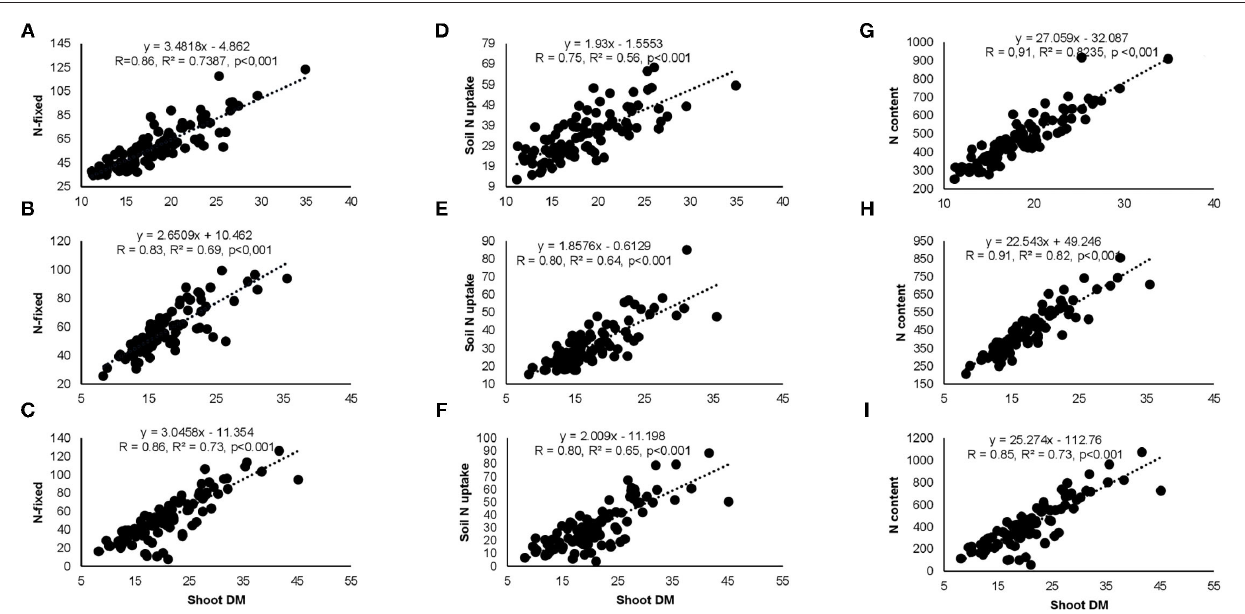
FIGURE 5 | Correlation and regression analysis between shoot DM and N-fixed at (A) Nyankpala, (B) Savelugu, (C) Gbalahi, and between shoot DM and soil N uptake at (D) Nyankpala, (E) Savelugu, (F) Gbalahi as well as between shoot DM and N content at (G) Nyankpala, (H) Savelugu, and (I)